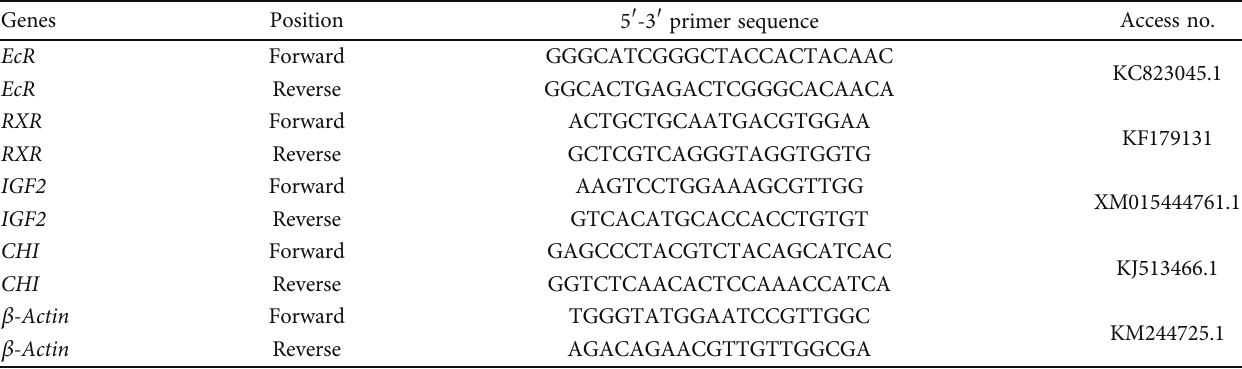
Table 2: Primer sequences used for real-time